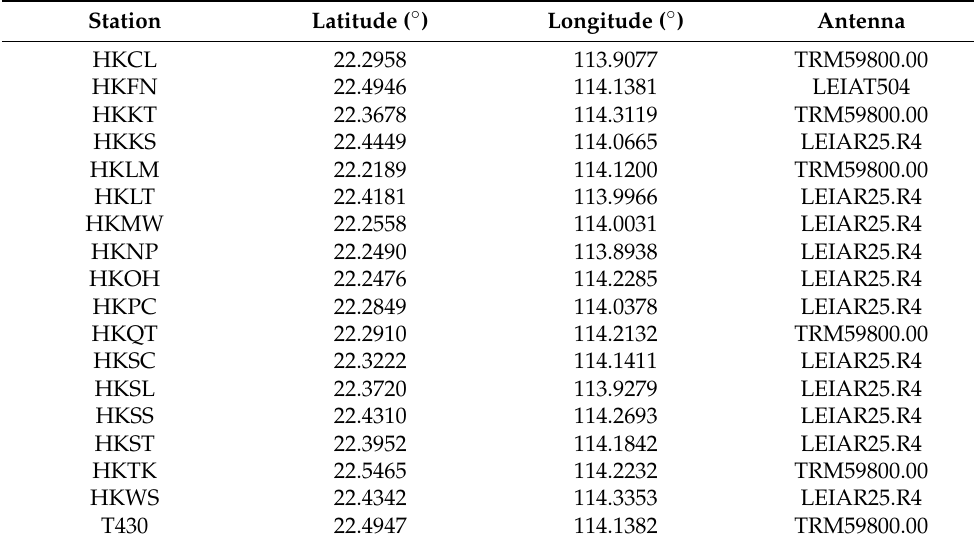
Figure 2. GNSS station and RS station position distribution map. Table 1. Hong Kong CORS coordinates list.